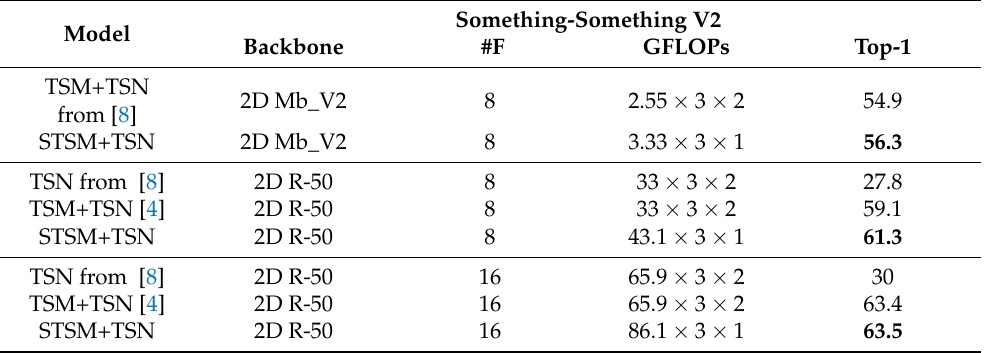
Table 5. Comparison of STSM embedded in different backbones and different number of input frames on the validation set of the Something-Something V2